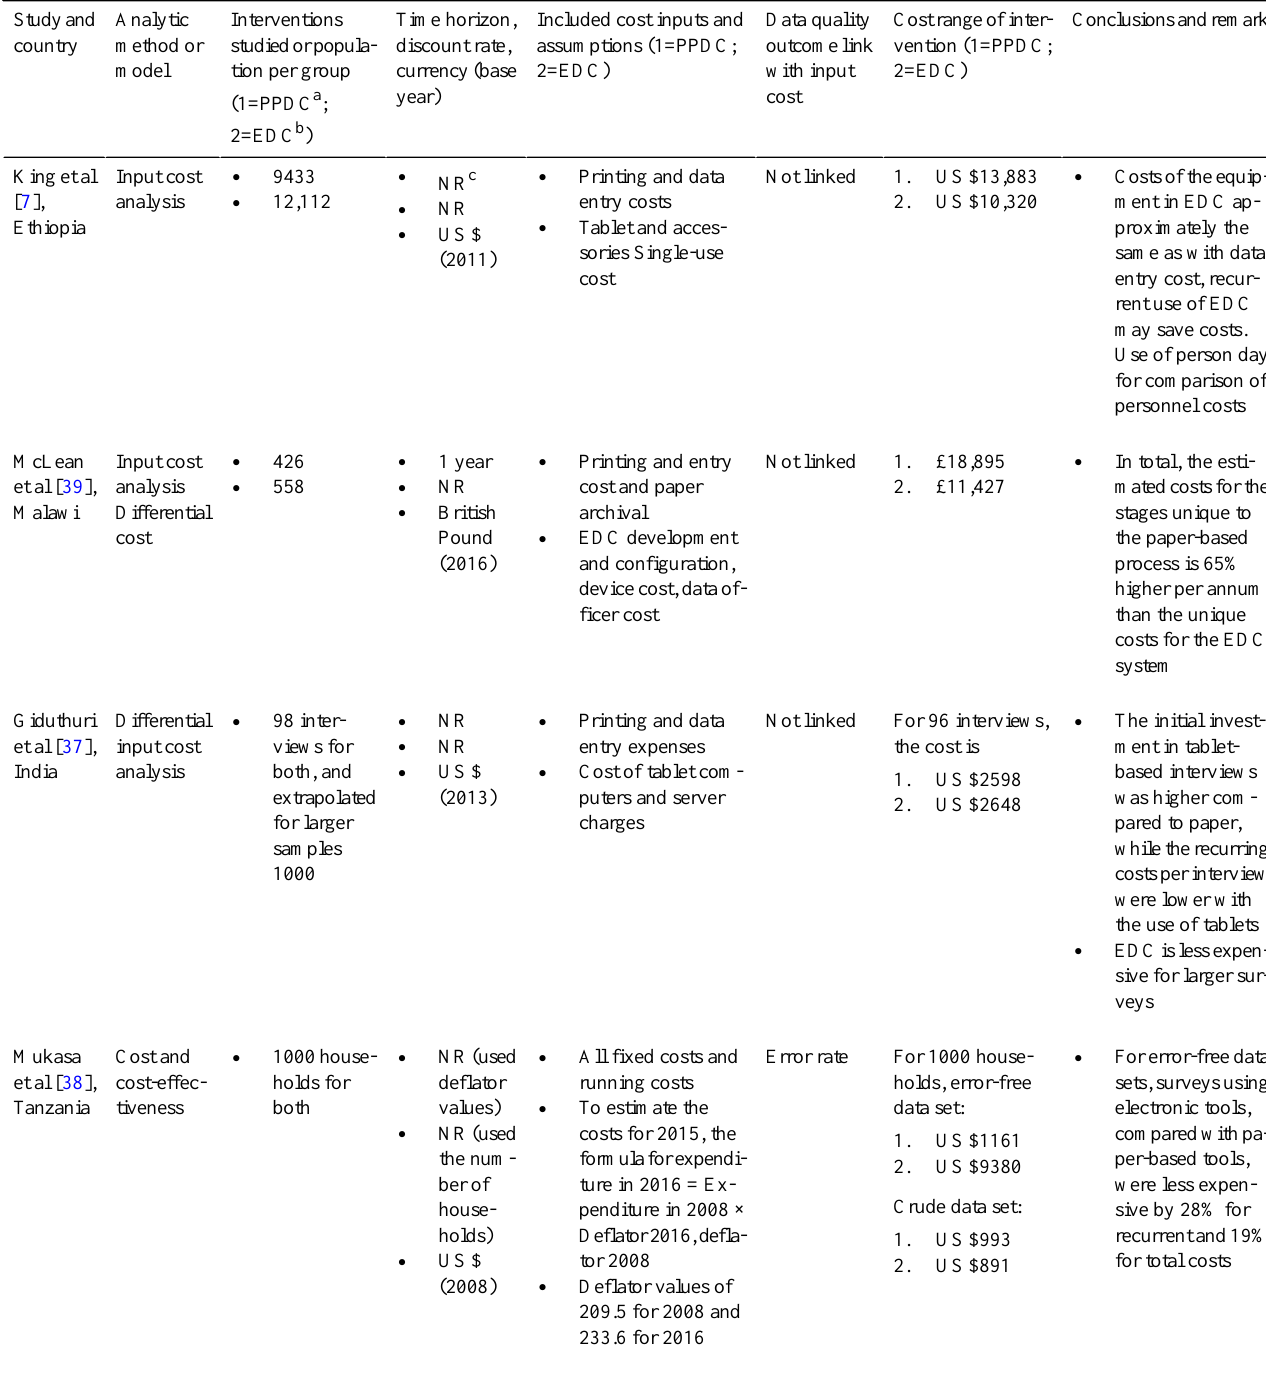
Table 4. Extracted cost information (based on Consolidated Health Economic Evaluation Reporting Standards evaluation template)